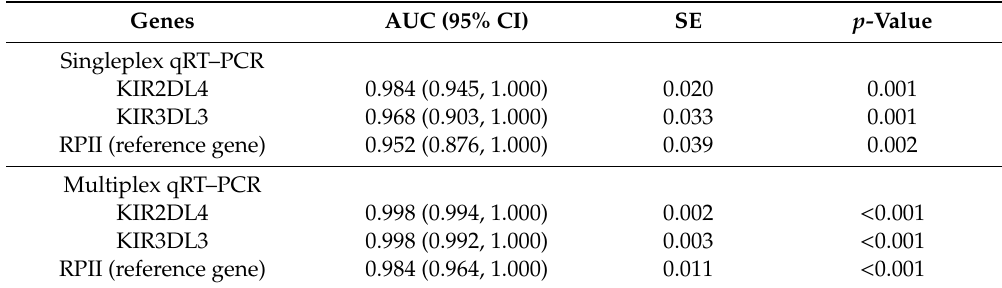
Table 2. Area under the ROC curve analysis of killer-cell immunoglobulin-like receptors (KIR) gene expressions in healthy donors.